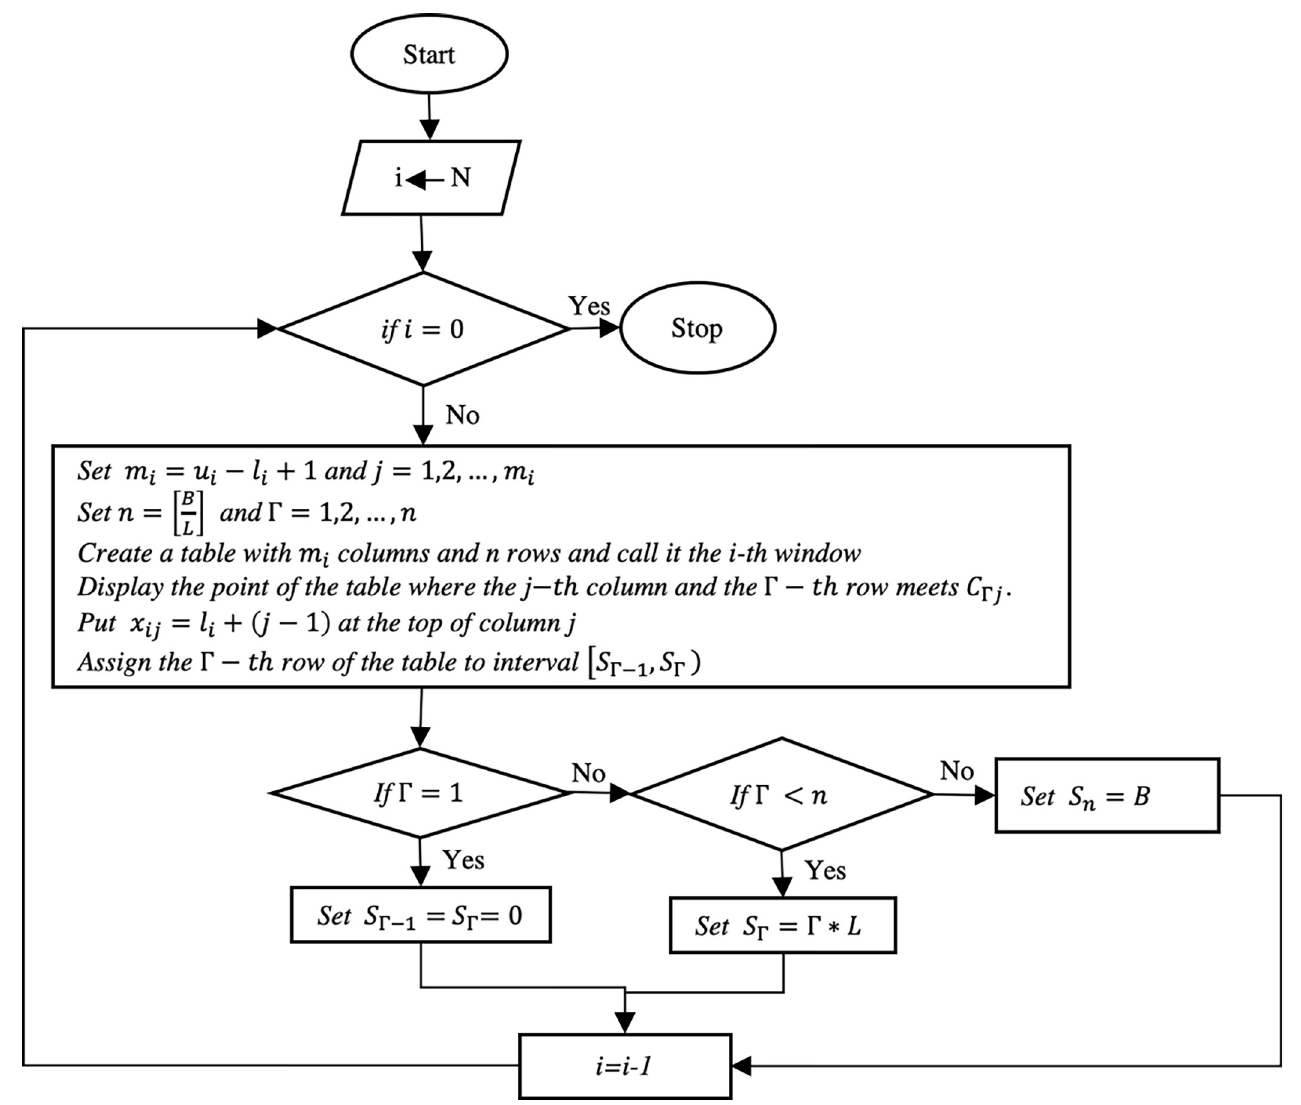
code results (S2 Appendix). Eventually, Information on the objective function and variables for different values of λ in the interval [–2 2] with a step length of 0.05 is provided in S3 Appendix. According to the results, the first place where K in the cardinality constraint equals 2 ( K = 2) is where λ is -1.1( λ � = − 1.1). Eventually, this model was solved by the proposed algo- rithm code based on dynamic programming provided in S4 Appendix. The software output is provided in S5 Appendix. The results include y � 7 ; x � ¼ 6 ; Z ¼ 32 : 9346 ð Z ¼ max 4 to precede. Moreover, to gain validity and reliability of the designed code, the case study is manually solved in the form of dynamic scheduling tables (S6 Appendix). Table 2 shows the results of various changes in the state by changes in the step length ( L ) belonging to budget intervals and sensitivity